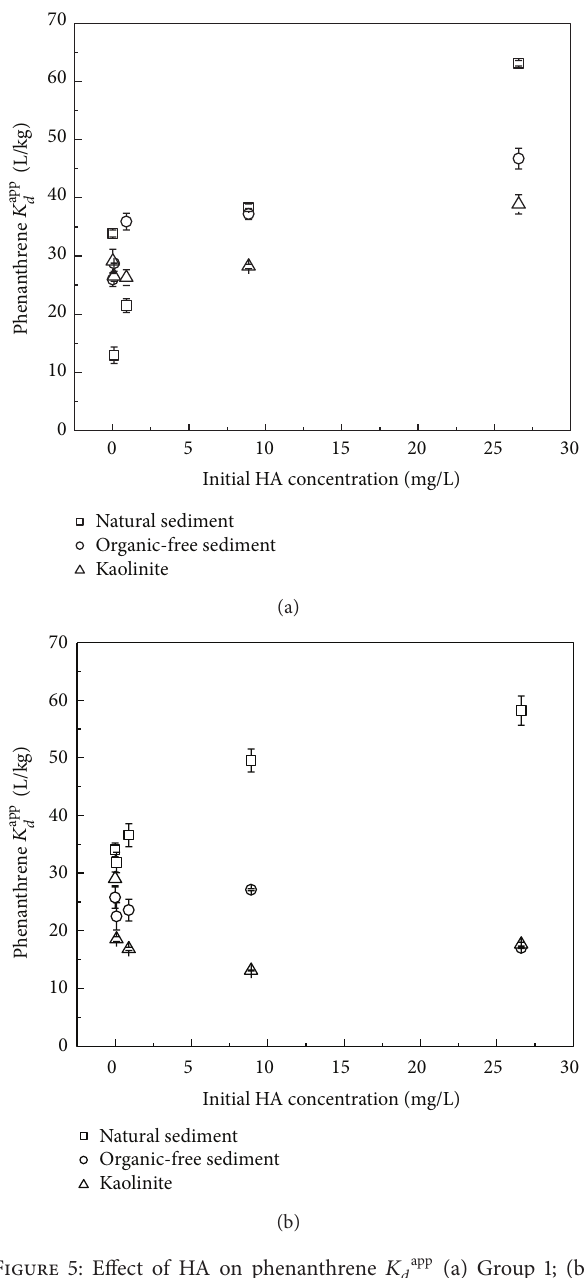
Figure 5: Effect of HA on phenanthrene 𝐾 𝑑 app (a) Group 1; (b) Group